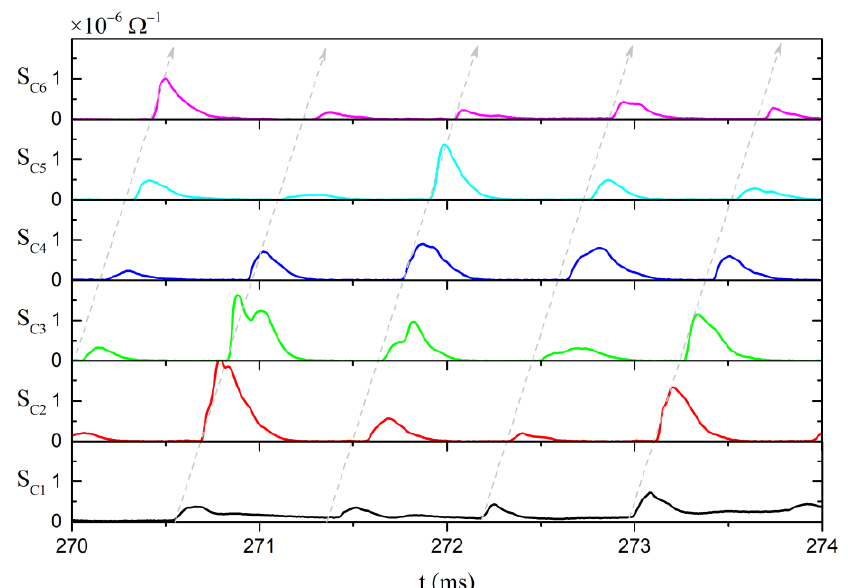
Figure 17. A fragment of the records of 6 ISs in the circumferential line, indicating the rotation of a detonation wave in the annular RDE combustor at a tangential velocity approximately corresponding to the slope of the dashed lines (about 1100 m/s).